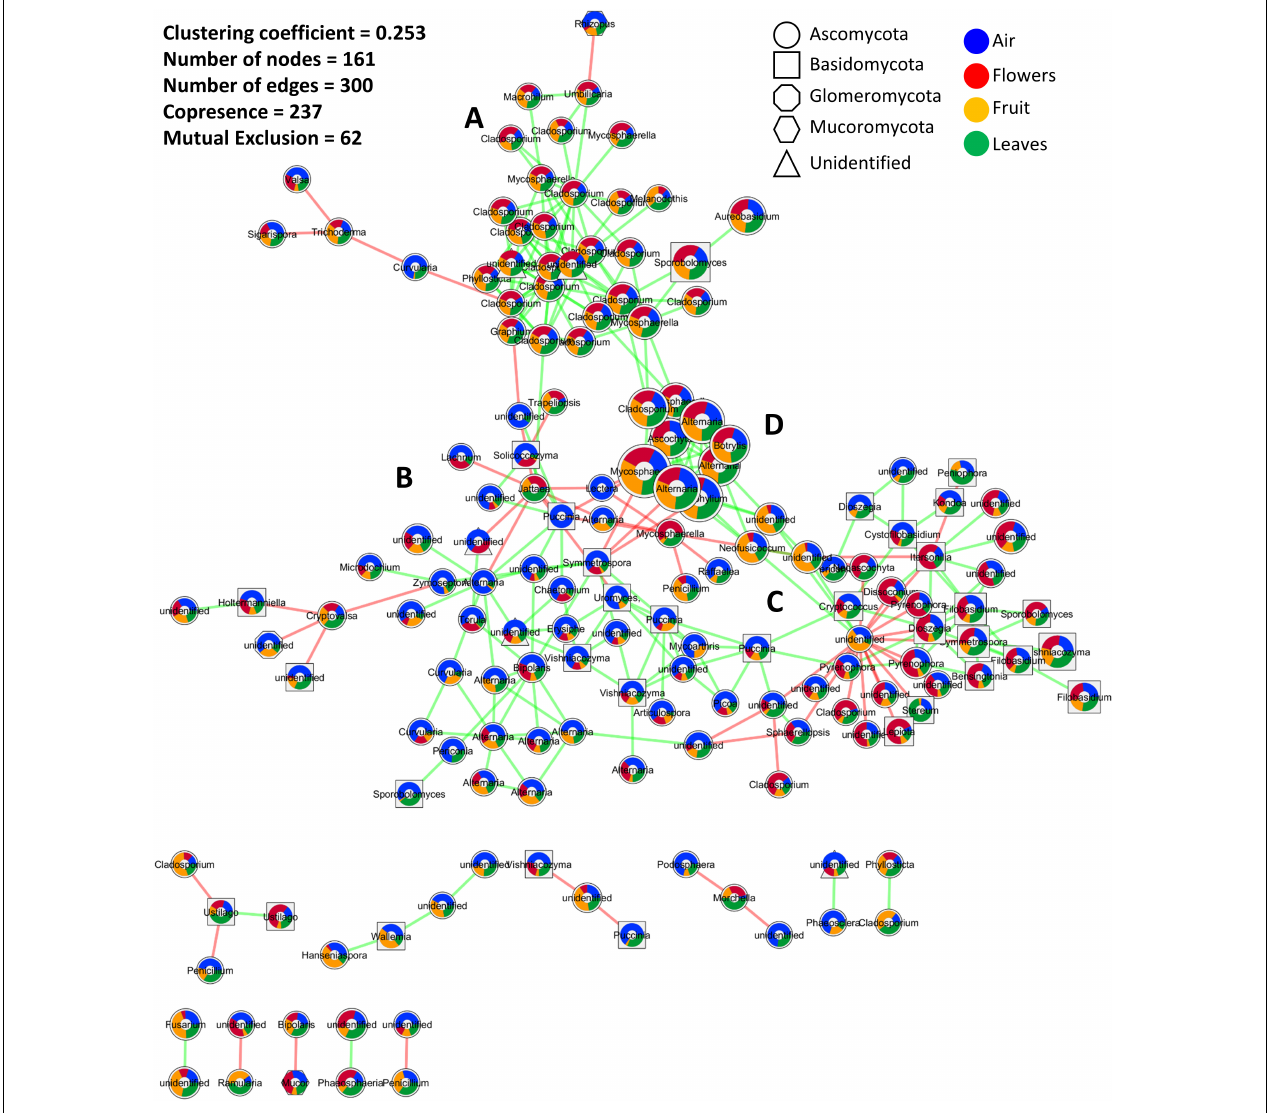
FIGURE 3 | Microbial association network showing interactions (co-occurrence and mutual exclusion) represented by green and red links, respectively. The size of the nods indicates the average relative abundance of OTUs across all investigated samples, while colored pie charts embedded inside the nodes show the relative distribution of each OTU in different samples (air, flowers, fruit, and leaves). Node shapes are used to differentiate fungal phyla. (A–D) are used to indicate the four sub-clusters that appeared to be influenced by the average relative abundance distribution of the interacting OTUs in the investigated samples. Interactions were calculated by CoNet, clustered using Connected Components algorithm as implemented in clusterMaker2, and visualized in Cytoscape